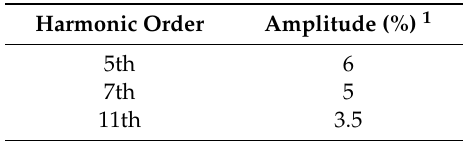
Table 3. The amplitude of each harmonic during the test.